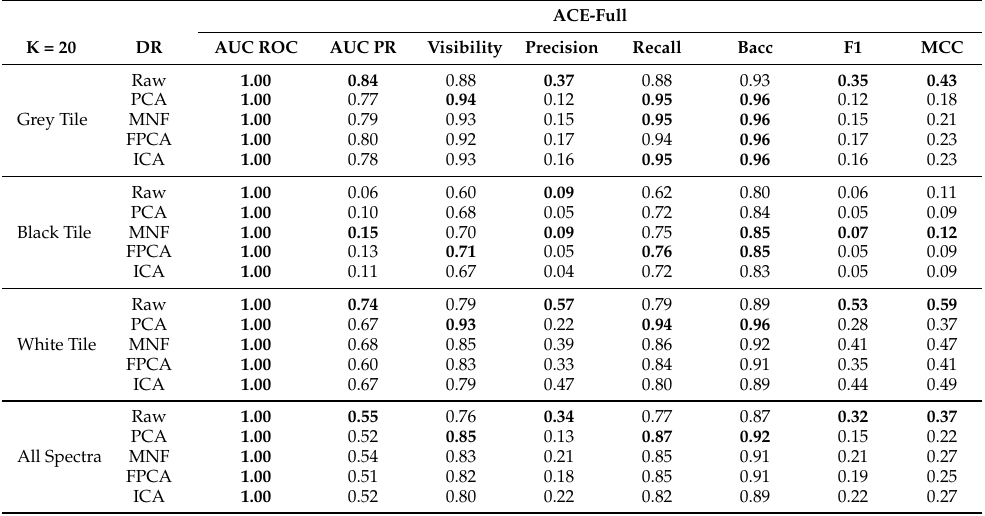
Table 5. Average performance measures for each target in the OP7 dataset without spatial DR applied using the ACE algorithm.